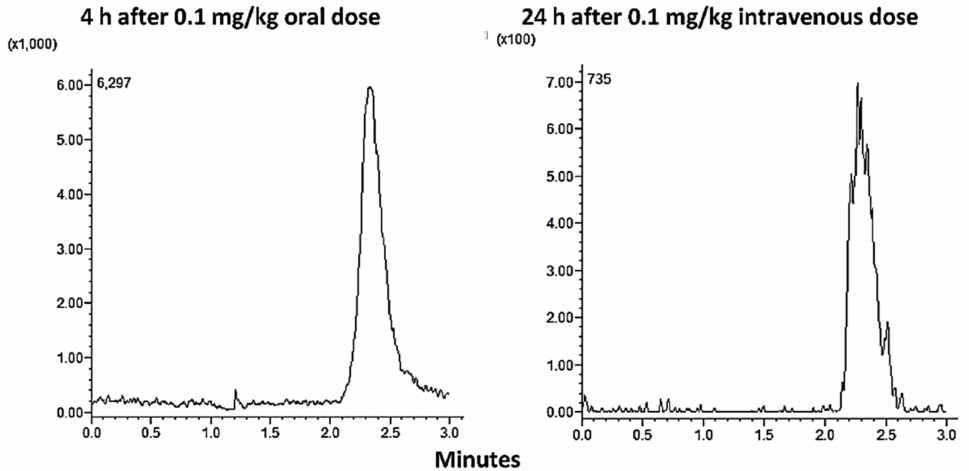
Figure 3. MRM ion-chromatograms from rats given 0.1 mg/kg colchicine (full profiles shown in Figure 6). Assayed samples were blood drawn at 4 h after an oral dose, and 24 h after an intravenous